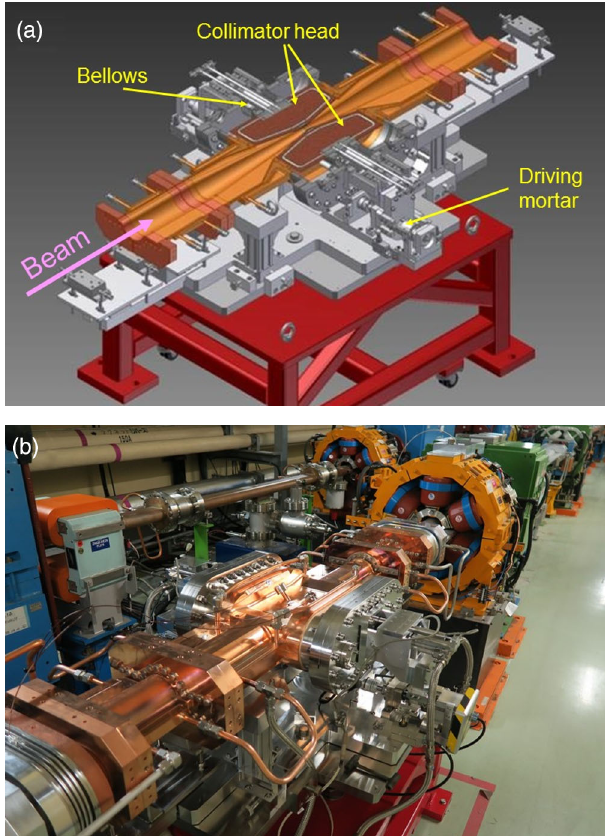
FIG. 7. (a) Conceptual structure and (b) test model of the new beam collimator installed in the LER arc